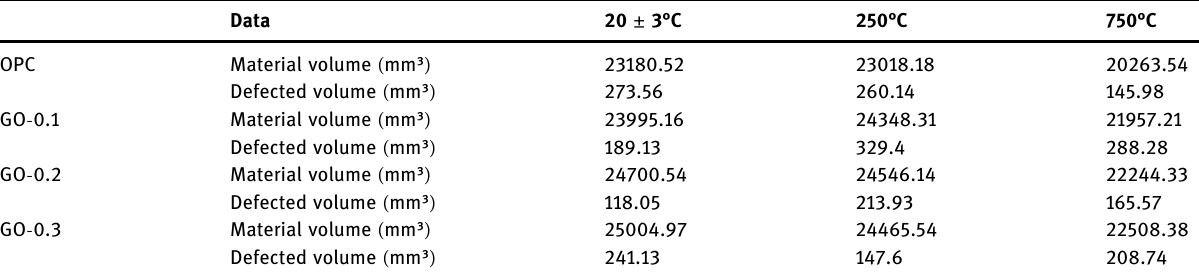
Table 3: Micro - CT data for material